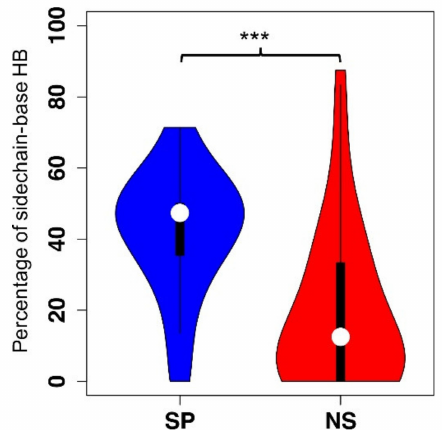
Figure 2. Comparison of the distribution of the percentage of the sidechain-base hydrogen bonds in each protein chain–ssDNA complex between the specific (SP) and the non-specific (NS) protein– ssDNA complexes. Statistical analysis of the comparison between the NS and SP groups was done with Wilcoxon rank sum test. *** = p -value ≤